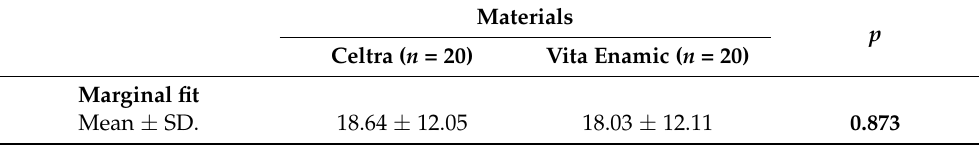
Table 4. Comparison between marginal fit ( µ m) of the two studied